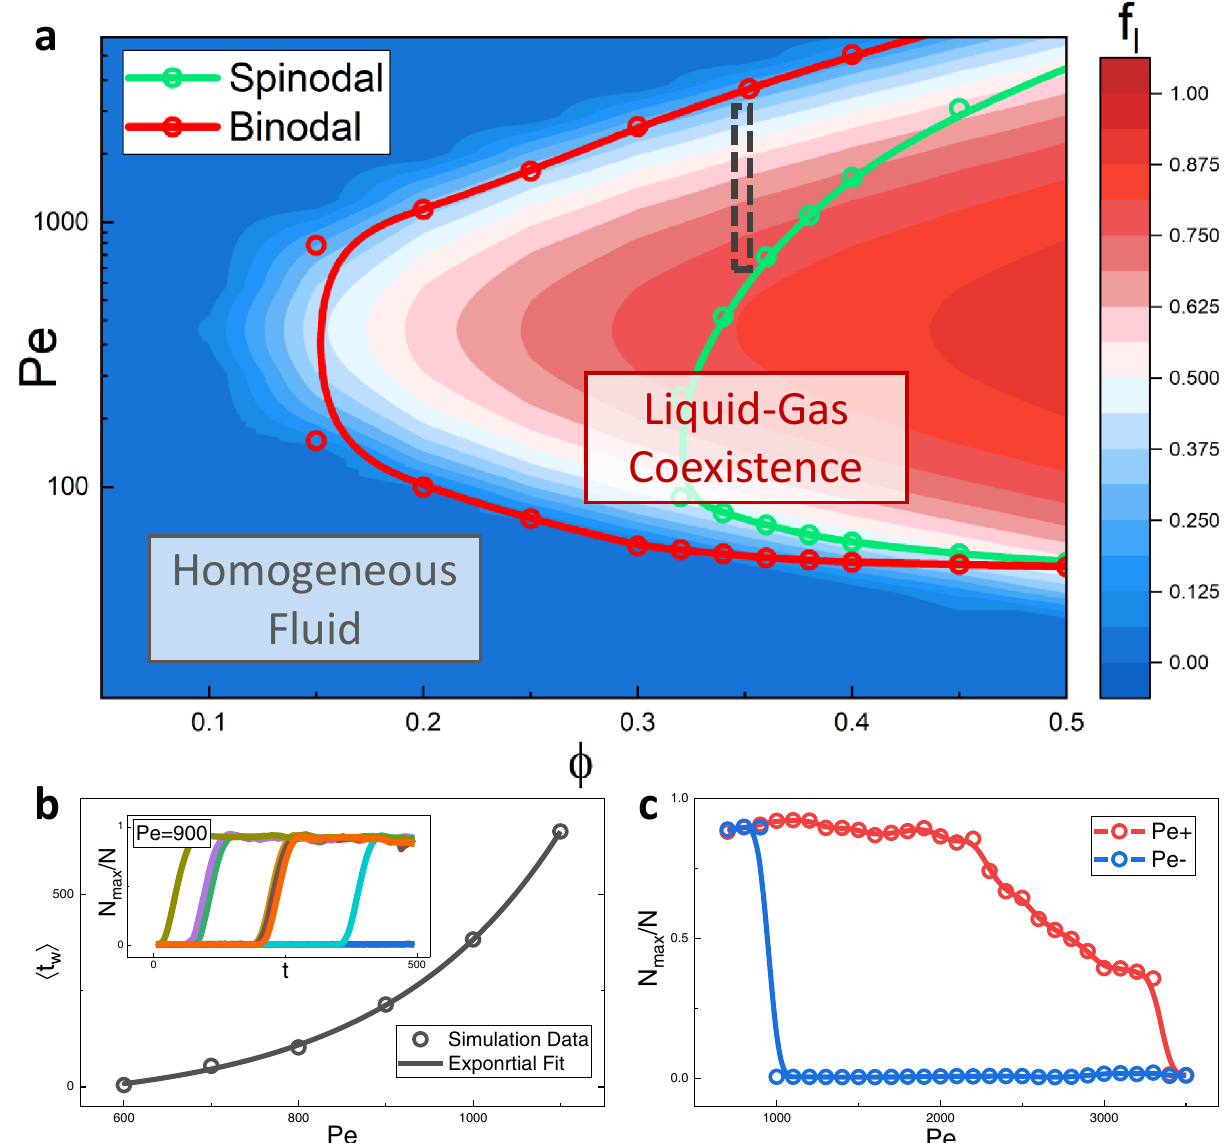
Fig. 1 The reentrant MIPS. a Phase diagram in the Pe − ϕ plane. The colored background is obtained by the kinetics model with λ = 2.8 × 10 − 4 and κ = 0.9. f l is the fraction of dense phase. The red and green lines respectively represent the binodal and spinodal curves from simulations. b Dependence of the ensemble-averaged waiting time 〈 t w 〉 for the nucleation on Pe for active systems at ϕ = 0.35 inside the gray dashed box in a . Curves are the exponential fi tting for the simulation data. The inset is the dependence of N max = N with N max the particle number of the largest cluster on t for ten independent ensembles at ϕ = 0.35 and Pe = 900. c Hysteresis at ϕ = 0.35 including the gray dashed box in a . Simulation data are reached from two initial conditions: the fi nal con fi gurations of systems at slightly smaller Pe (red line and symbols) and the ones at slightly larger Pe (blue line and